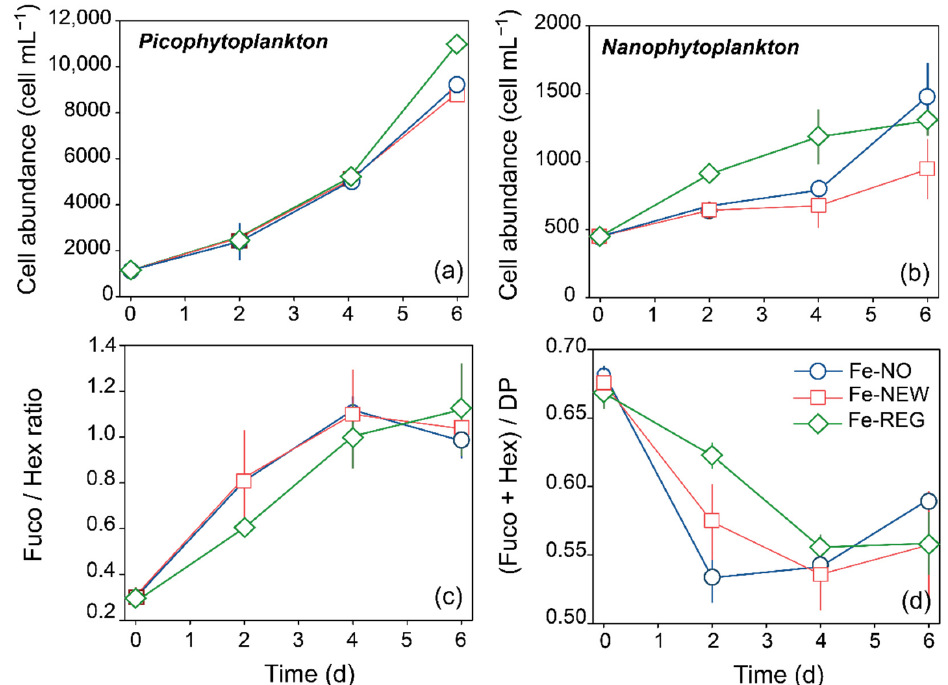
Figure 4. Time course of ( a ) picophytoplankton and ( b ) nanophytoplankton cell abundance measured by flow cytometry, of ( c ) the ratio of diatoms to haptophytes (Fuco/Hex ratio), and the ( d ) relative proportion of pigments assigned to diatoms and haptophytes (Fuco + Hex/DP). Error bars represent the standard deviation of triplicate incubation bottles.